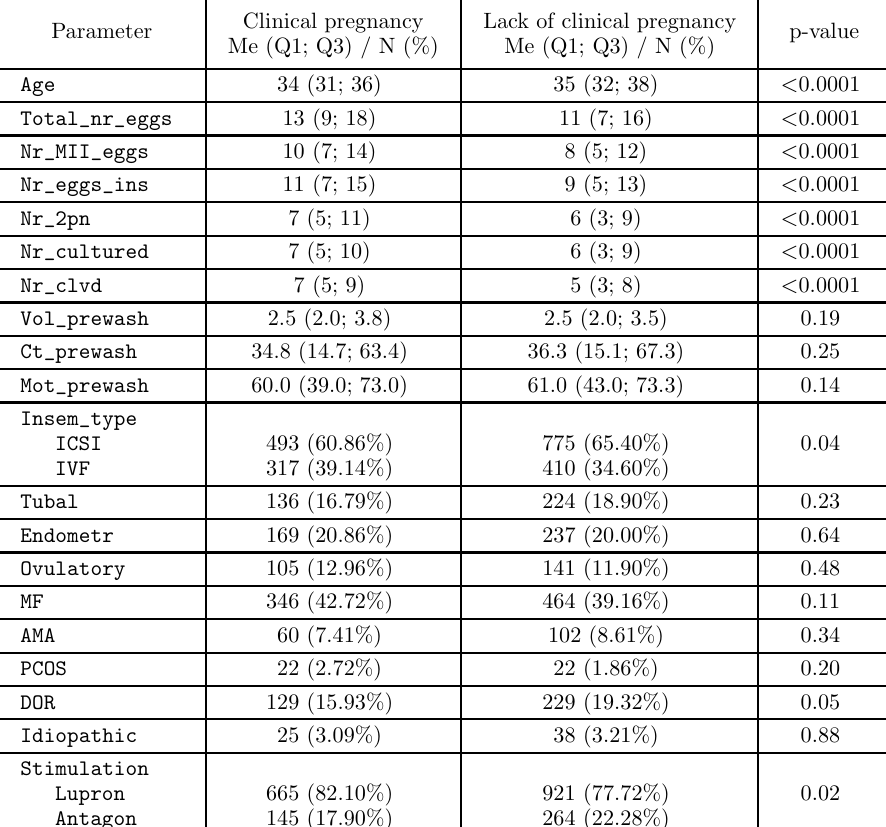
Table 2. Comparison of independent variables between pregnancy and non- pregnancy